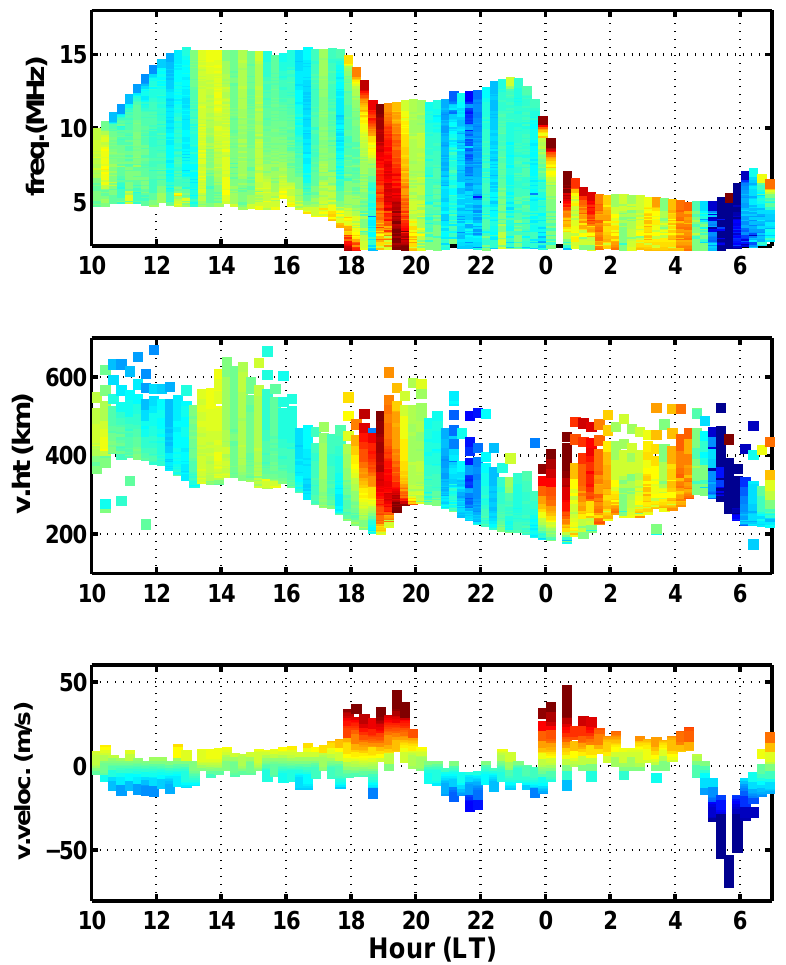
Fig. 7. Doppler derived vertical velocity plotted as a function of time (bottom), as a function of ionogram frequency (top) and virtual height (middle). The colour code for velocity used throughout can be read from the bottom panel in relation to the time dependence of velocity. Data from Sumedang as observed on the 1 November